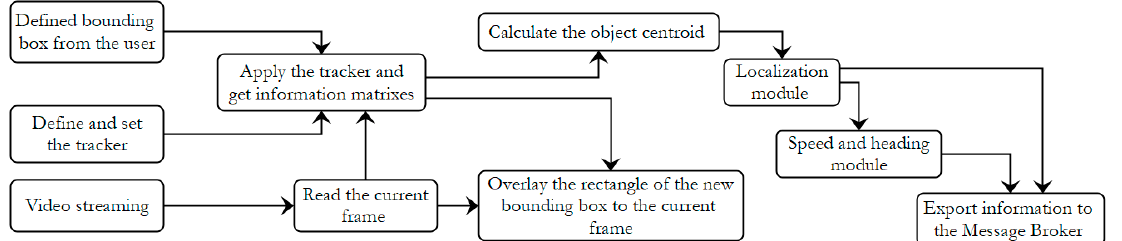
Figure 4. Workflow of the object tracking module.